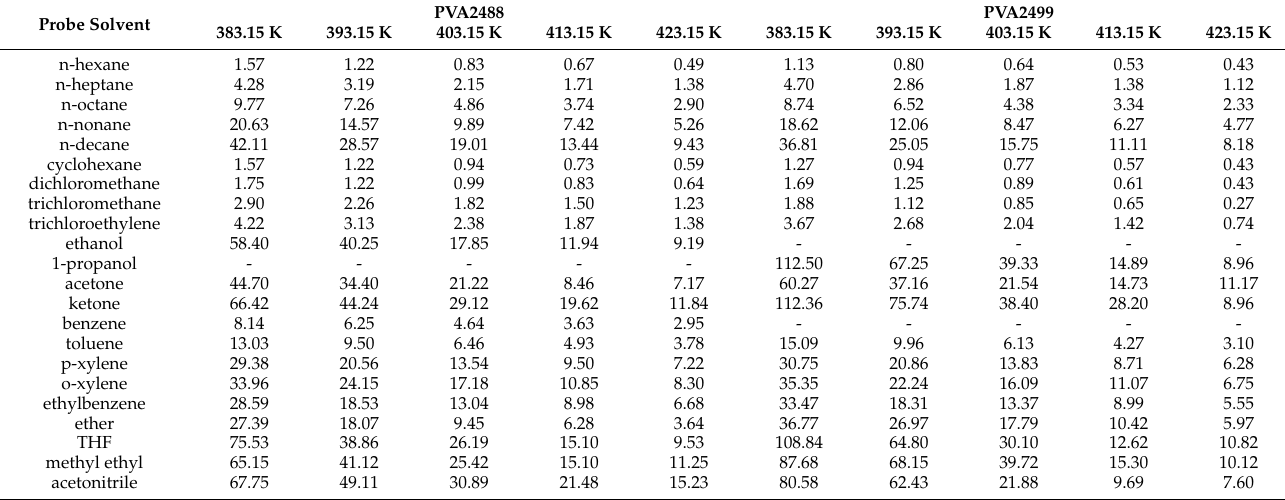
Table 2. Specific retention volumes at different temperatures V 0 g